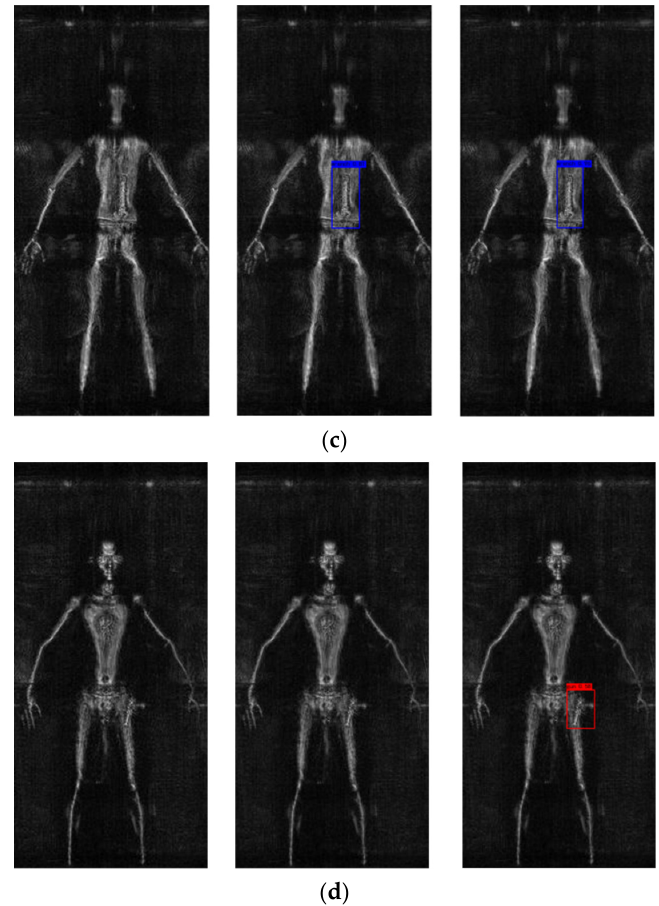
Figure 11. Schematic diagram of each network F1. ( a ) Test photo 1. ( b ) Test photo 2. ( c ) Test photo 3. ( d ) Test photo 4. Table 3. Comparison of false alarm rate and miss alarm rate.